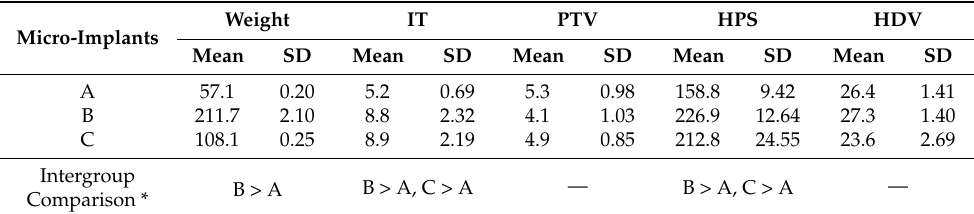
Table 2. Mechanical strengths (IT, PTV, HPS, HDV) analysis of microimplants in the Kruskal-Wallis H-test with a Dunn’s post hoc comparison test.